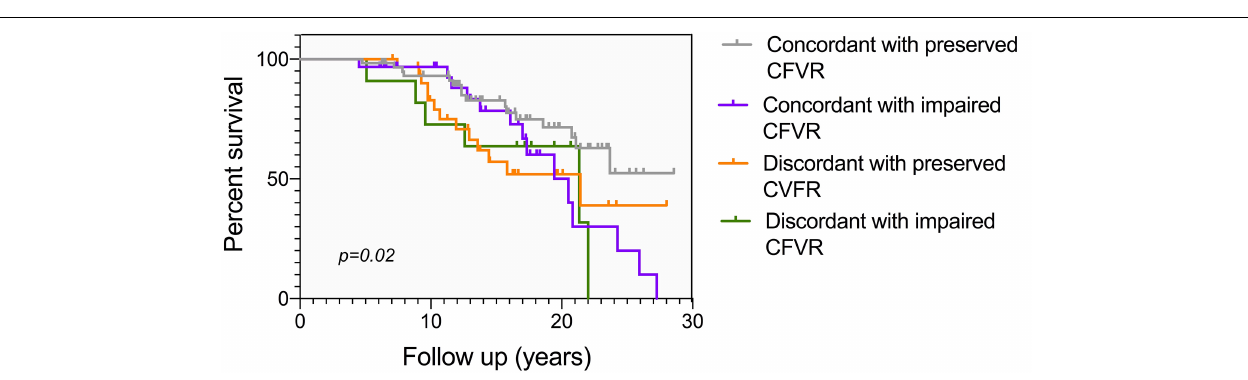
FIGURE 4 | Kaplan Meier mortality curve according to different CFVR endotypes, conditional at 5-years survival. As in Figure 3 , endotype 2 has the lowest mortality, while endotype 1 and endotype 3 share a comparable survival. Endotype 4 has the highest mortality, with no patients surviving more than 21 years after HT. Different endotypes can significantly predict survival ( p =